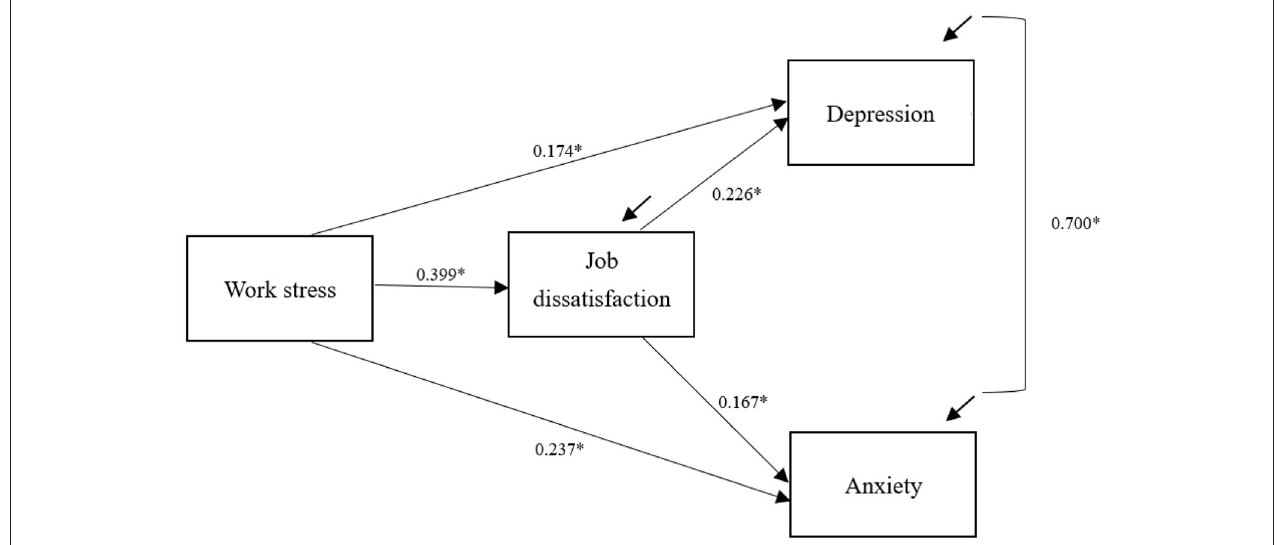
FIGURE 1 | The proposed model with standardized coefficients. * p < 0.05. For simplicity reasons, the demographic variables controlled in the model are not presented in the figure. Gender was significantly associated with depression ( β = 0.08, p < 0.01) and anxiety ( β = 0.08, p < 0.01). Age was significantly associated with depression ( β = − 0.09, p < 0.05) and anxiety ( β = − 0.07, p < 0.01). Education level was significantly associated with depression ( β = − 0.05, p < 0.01). Smoking was significantly associated with depression ( β = 0.04, p < 0.01) and anxiety ( β = 0.04, p <